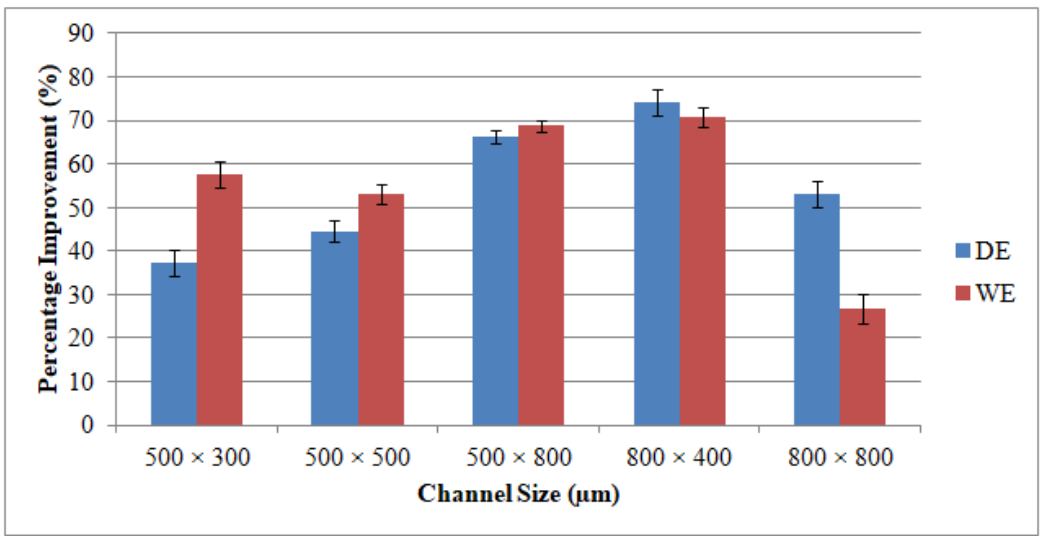
Figure 13. Percentage of improvement in the dimensional accuracy of the fabricated channels by using LRUM comparing to LBM.